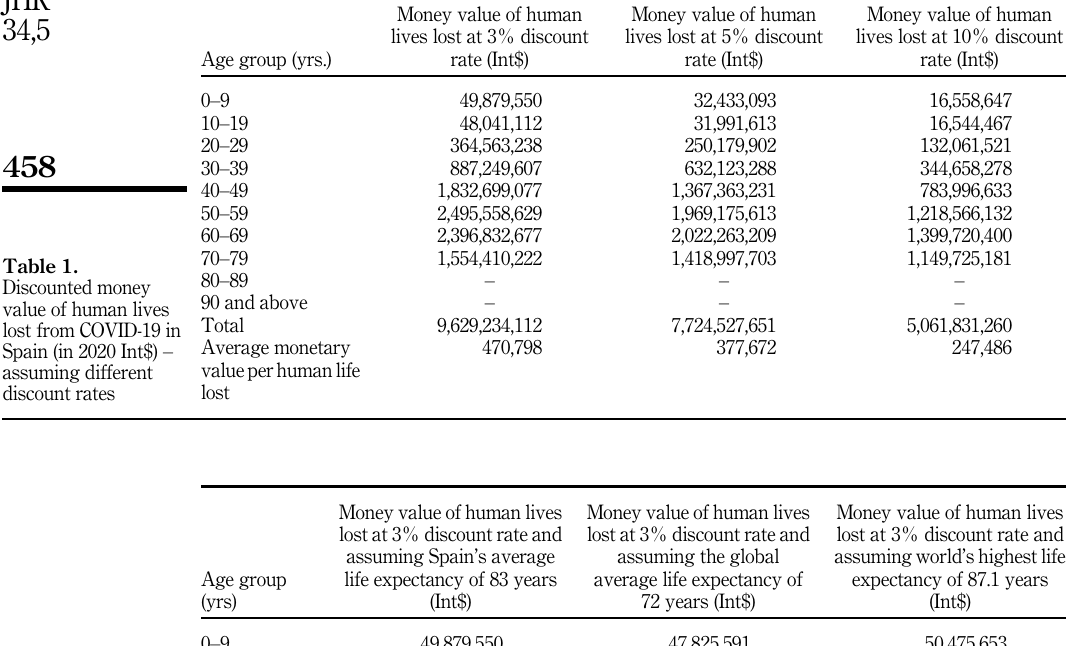
Table 2. A comparison of the money value of human lives lost from COVID- 19 in Spain: assuming Spain ’ s, global and world ’ s highest life expectancies